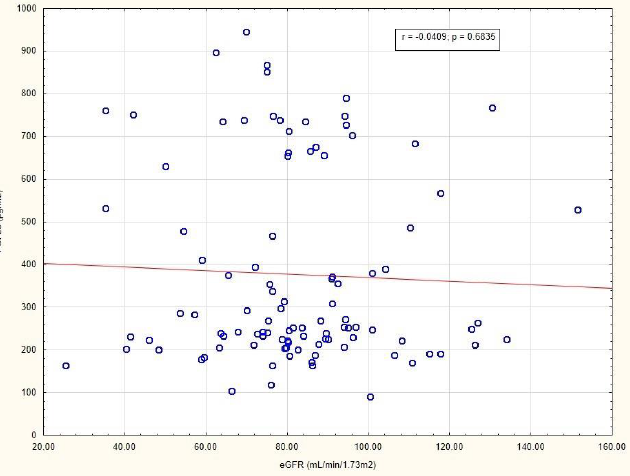
Figure 4. Correlation between eGFR and FGF23 levels in patients with long-standing type 2 diabetes mellitus. Abbreviations: eGFR, estimated glomerular filtration; FGF23, fibroblast growth factor 23.